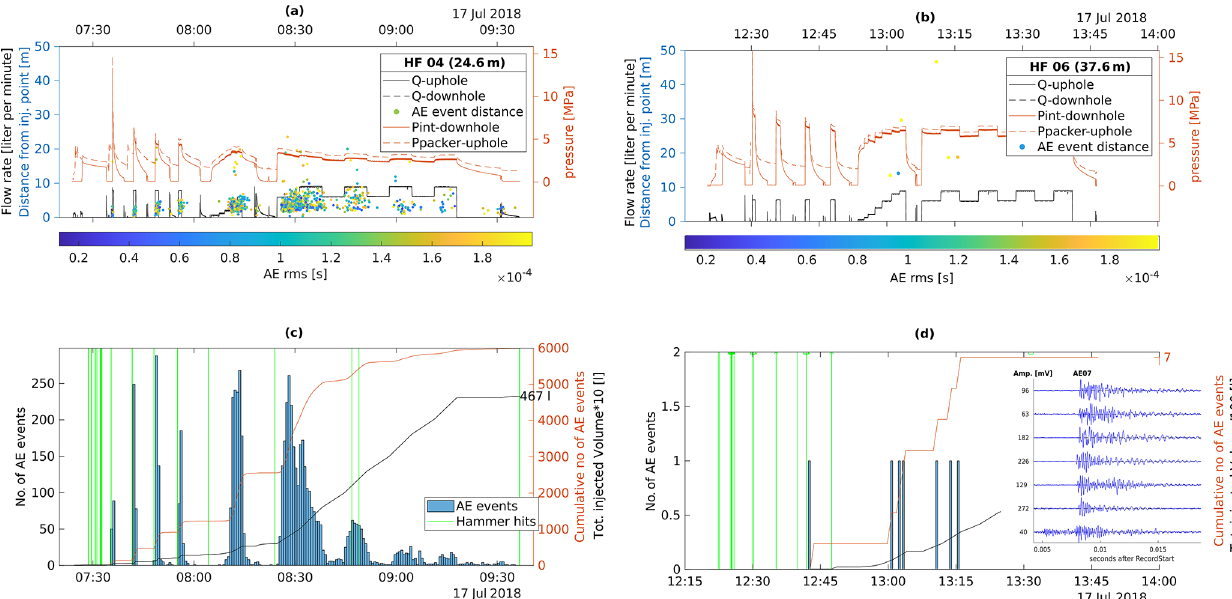
Figure 6. Stimulation sequence consisting of a frac, three refracs, step-rate pump test and periodic pumping test for the intervals at 24.6 and 37.6m borehole depths in the injection borehole. Panels (a) and (b) show flow rate (black) and pressure records (orange) measured in the intact intervals downhole and at the wellhead uphole as well as the AE activity plotted with distance from the centre of the injection interval (coloured dots). Panels (c) and (d) show an AE event histogram (blue), the cumulative number (orange) of located AE events and the cumulative injected volume (black). Active hammer hits (green lines) were used as marker signals throughout the injection sequence. An example of all the AE events observed during stimulation of interval 37.6m as recorded by sensor AE07 is shown as an